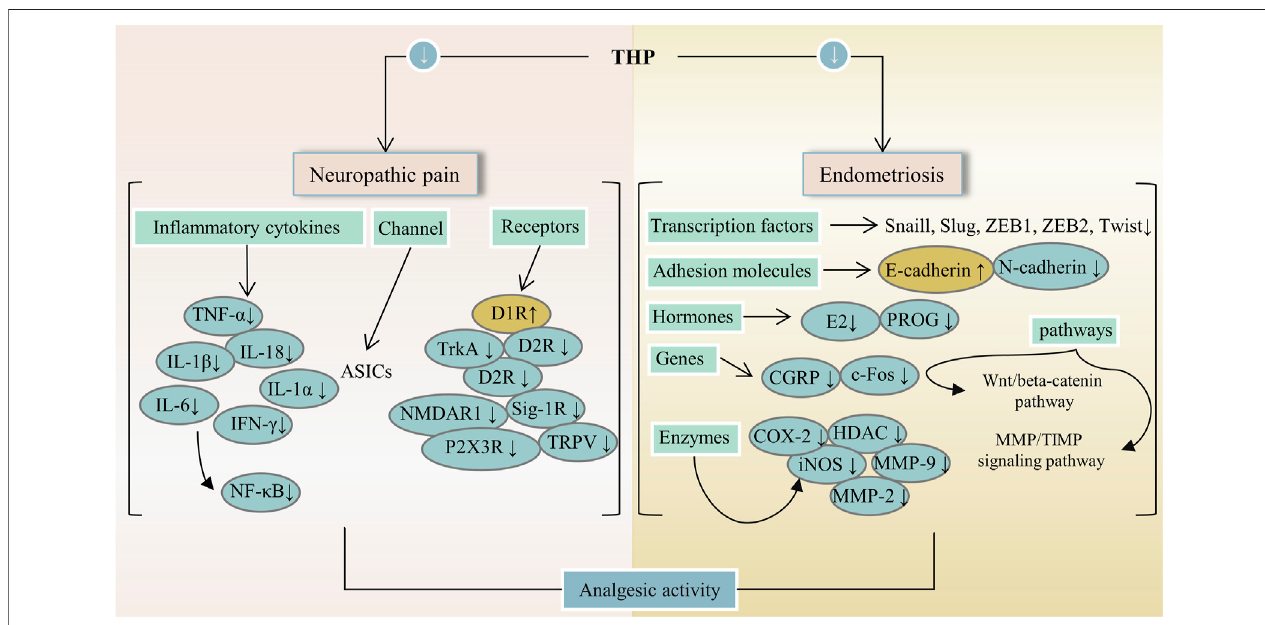
FIGURE 3 | The main targets and pathways of analgesic activity of THP. Abbreviations:THP, Tetrahydropalmatine; TNF- α , Tumor necrosis factor alpha; IL-18, Interleukin-18; D1R, Dopamine D-1 receptor; D2R, Dopamine D-2 receptor; TrkA, Tropomyosin receptor kinase A; Sig-1R, Sigma-1 receptor; NMDAR1, N-methyl-D- asparate receptor 1; TRPV, Transient receptor potential vanilloid; P2X3R, P2X purinergic ion channel type 3 receptor; ZEB1, Zinc fi nger E-Box binding homeobox 1; ZEB2, Zinc fi nger E-Box binding homeobox 2; E2, Estrogen; PROG, Progesterone; CGRP, Calcitonin gene-related peptide; HDAC, Histone deacetylase; iNOS, Inducible NO synthase; MMP-2, Matrix metalloproteinase-2; MMP-9, Matrix metalloproteinase-9; MMP/TIMP, Matrix metalloproteinase/tissue inhibitor of